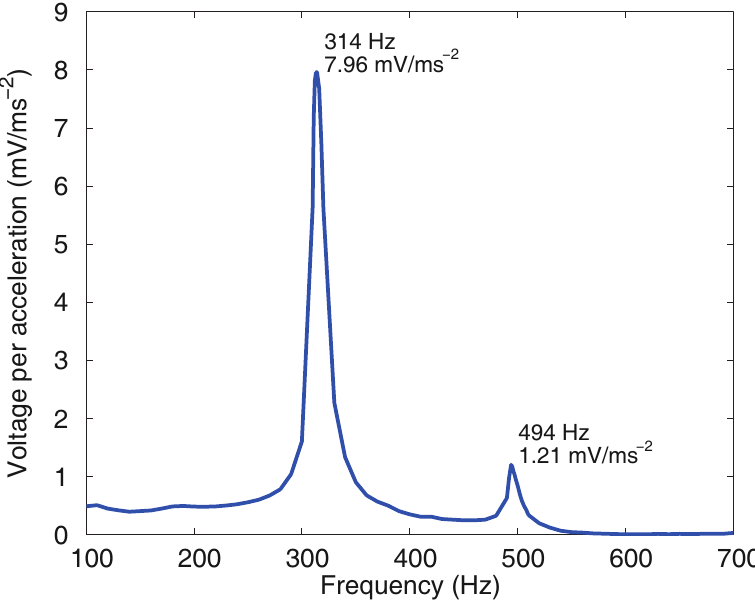
Figure 12. Output voltage per base acceleration as a function of the excitation frequency.